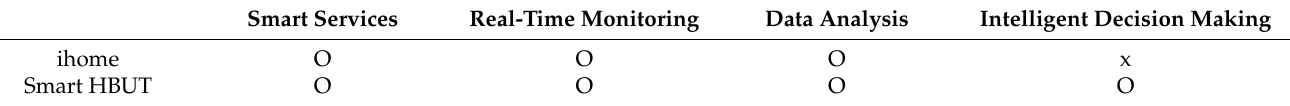
Table 8. Comparison with